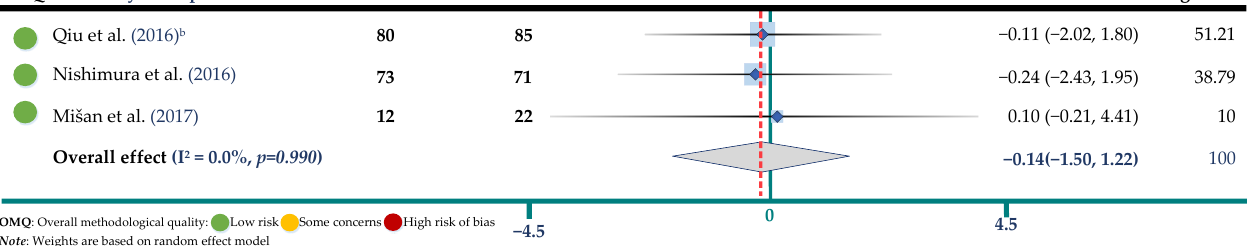
Figure 6. Meta-analysis of buckwheat supplementation and body weight. b indicates the Qiu study according to Table 2 [22,25,32].